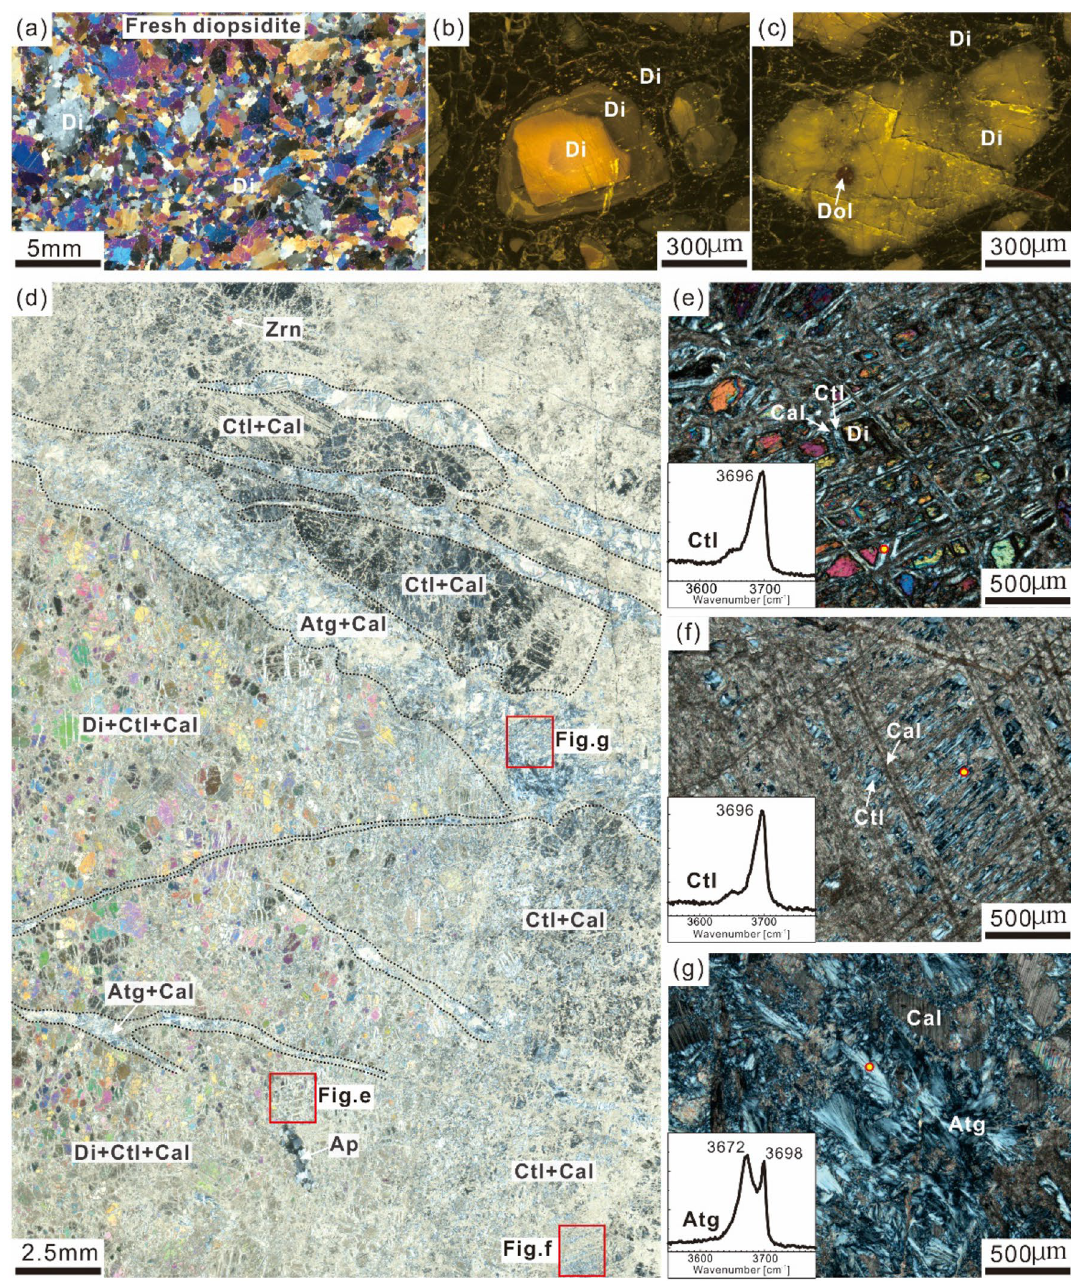
Figure 3. Microstructural features of fresh and serpentinized diopsidites from the Yushishan area. ( a , b , c ) Fresh diopsidites, ( b , c ) cathodoluminescence images, ( d-g ) photomicrographs of serpentinized diopsidite with the Raman peaks of chrysotile and antigorite. ( a ) Microstructure of fresh diopsidite under crossed ‐ polarized light. ( b ) Diopsides (Di) show the texture of compositional zoning. ( c ) Cathodoluminescence images, diopside including dolomite (Dol). ( d ) Image of scanned full thin section showing heterogeneous serpentinization of diopside (Di) as well as with a late antigorite (Atg) + calcite (Cal) vein, apatite (Ap), zircon (Zrn). ( e ) Serpentinization occurred along the cleavage plane of diopside forming chrysotile (Ctl) + calcite (Cal) + relict diopside. ( f ) Completely serpentinized pseudomorph with chrysotile + calcite. ( g ) Late antigorite (Atg) + calcite